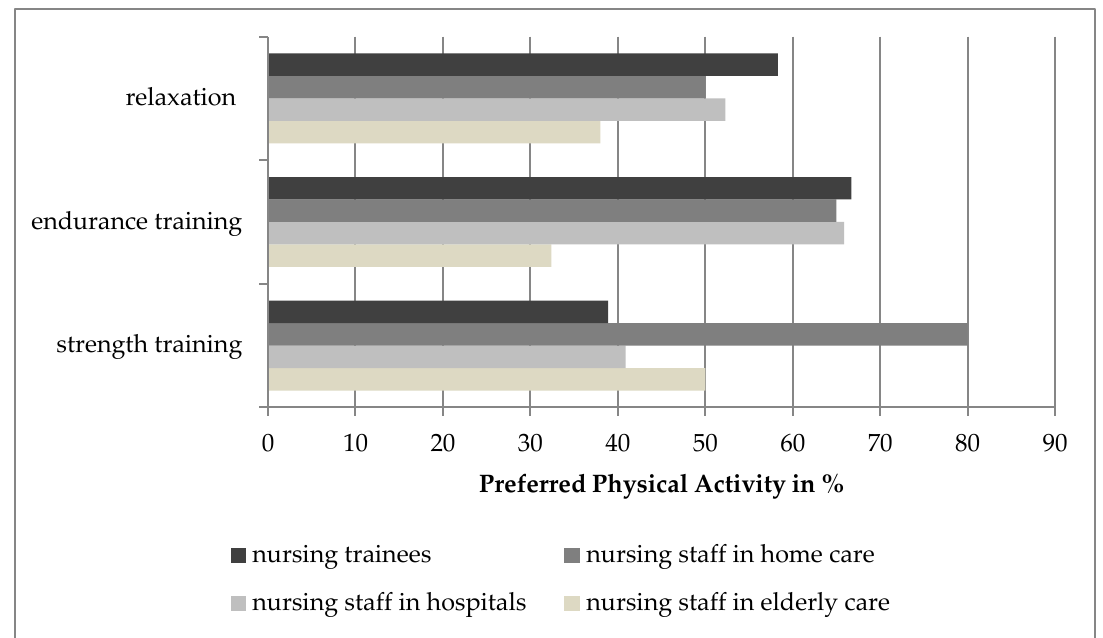
Figure 2. Preferred physical activities (multiple selections allowed). Figure 2 . Preferred physical activities (multiple selections allowed). Figure 2 . Preferred physical activities (multiple selections allowed).